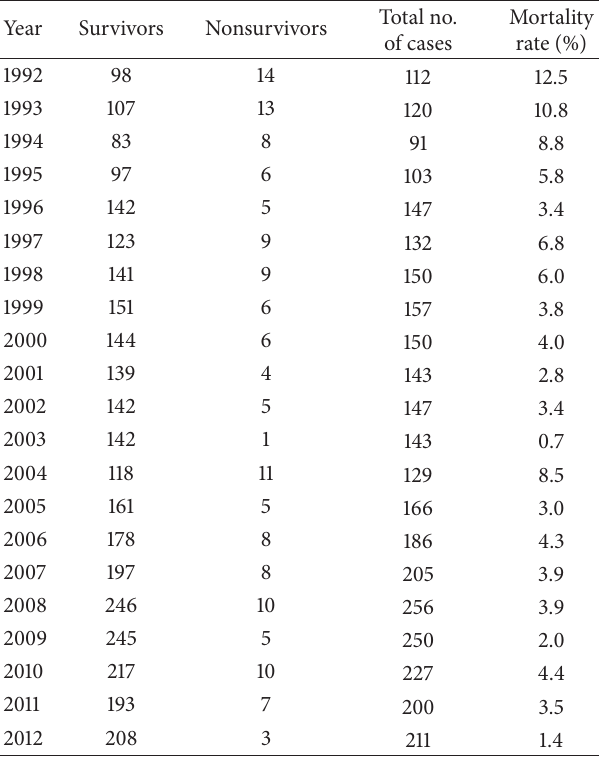
Table 1: Mortality rate in the burn unit of HC-FMRP-USP-Brazil from 1992 to